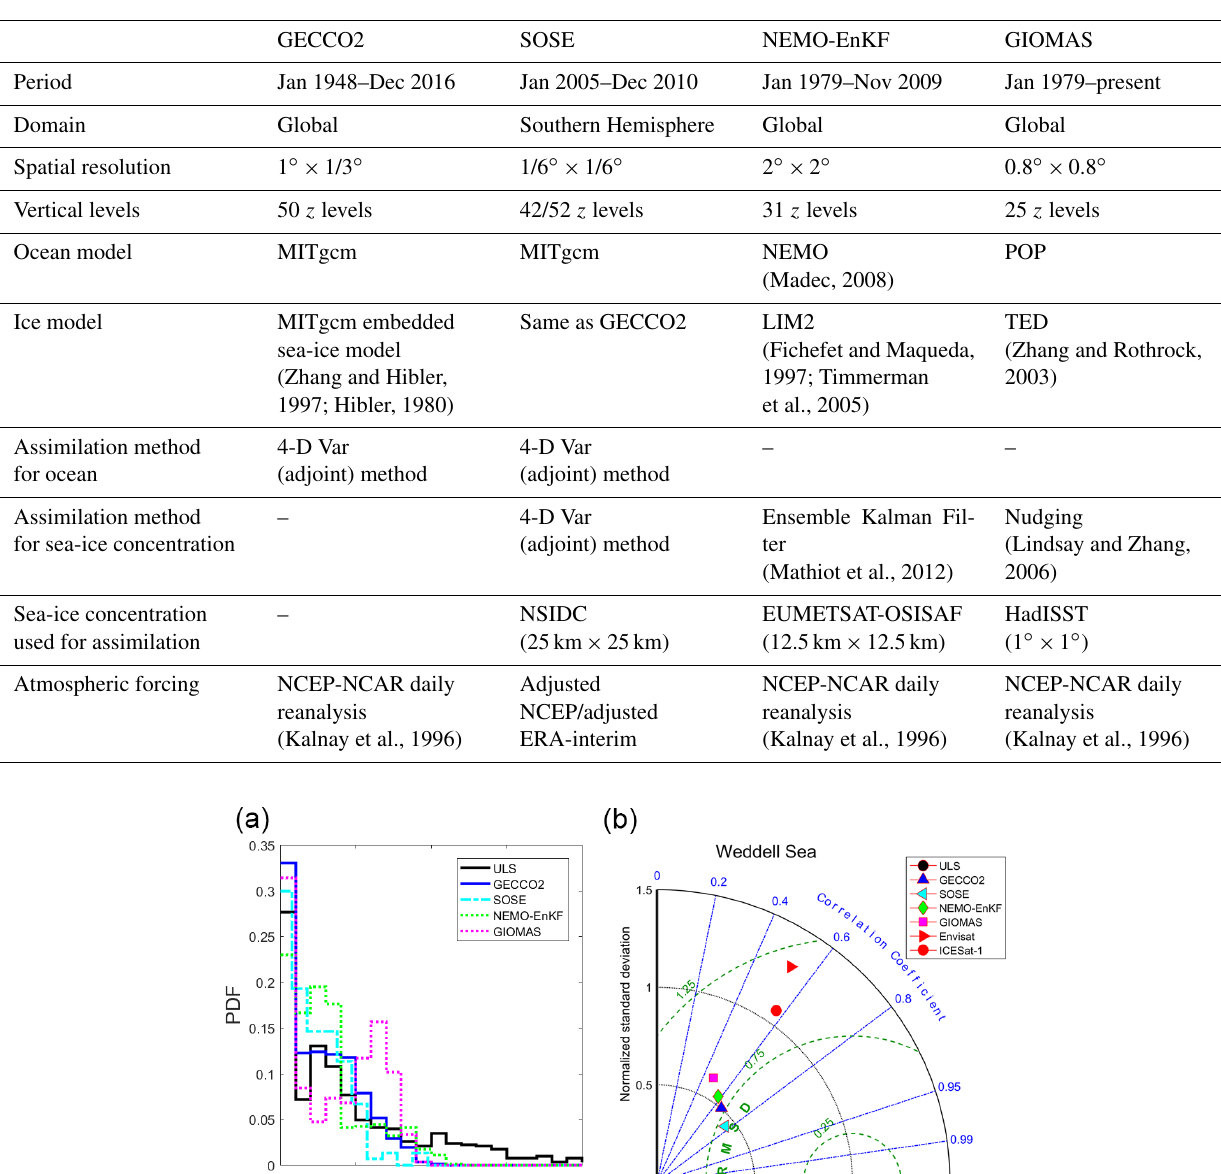
Table 1. Introduction of the four reanalyses data systems used in this study. GECCO2